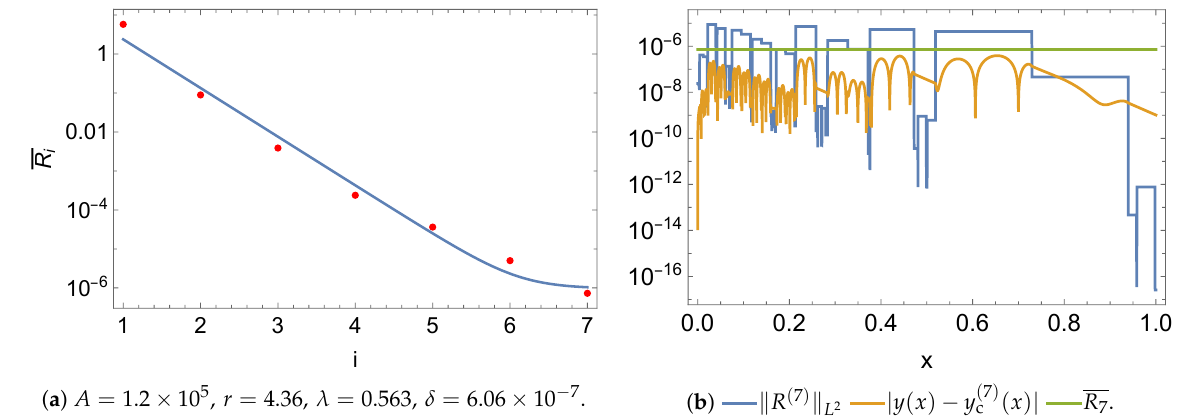
Figure 1. ( a ) The approximating polynomial y ( b ) Plot of the statistic ω i . ( ) ω i ≈ 0.6.